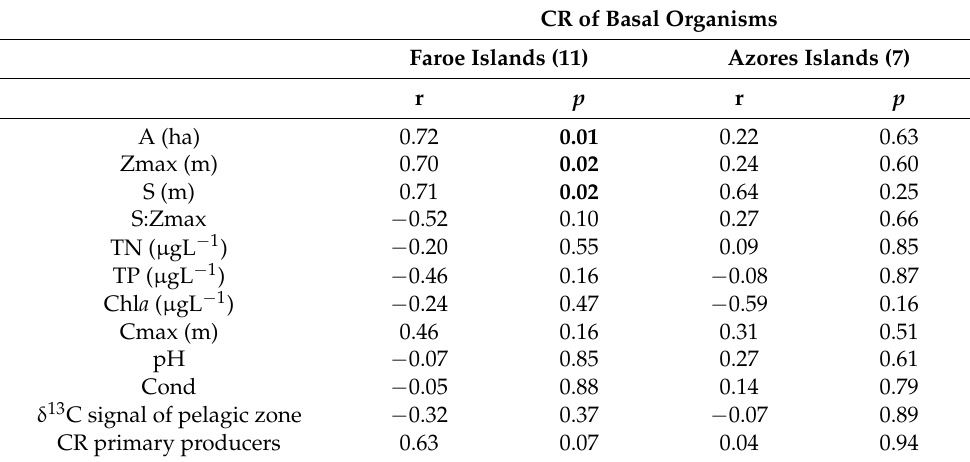
Table 5. Linear correlation analysis between the environmental variables and CR of basal organisms (log transformed) for the two islands. The number of lakes used in each analysis is given in brackets. For basal organisms, two lakes were excluded in the Azores Islands due to absence of invertebrates.